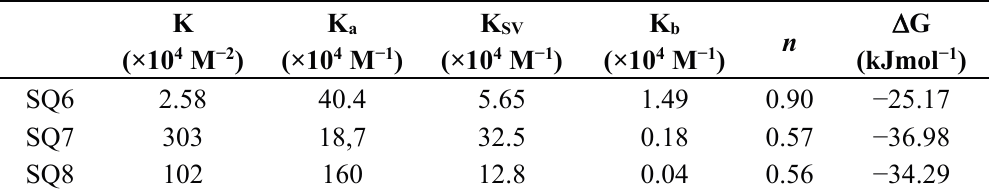
Table 2. Binding parameters for interaction of squarine dyes with BSA.